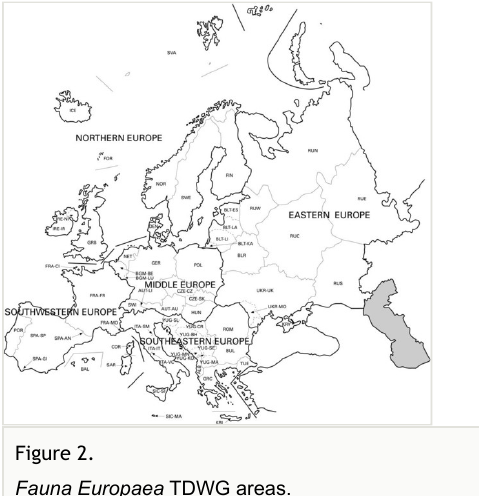
Figure 2. Fauna Europaea TDWG areas.